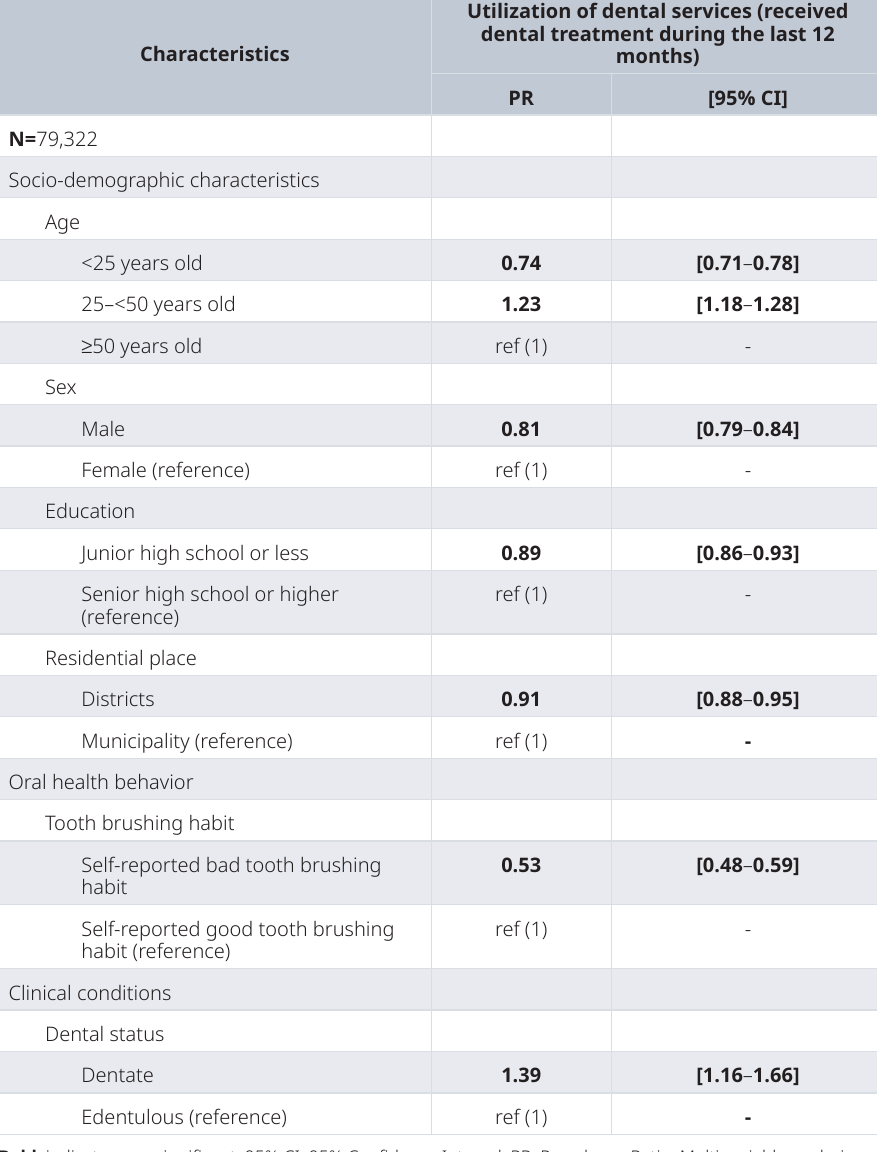
Table 3. Multivariable analysis of dental services utilization.